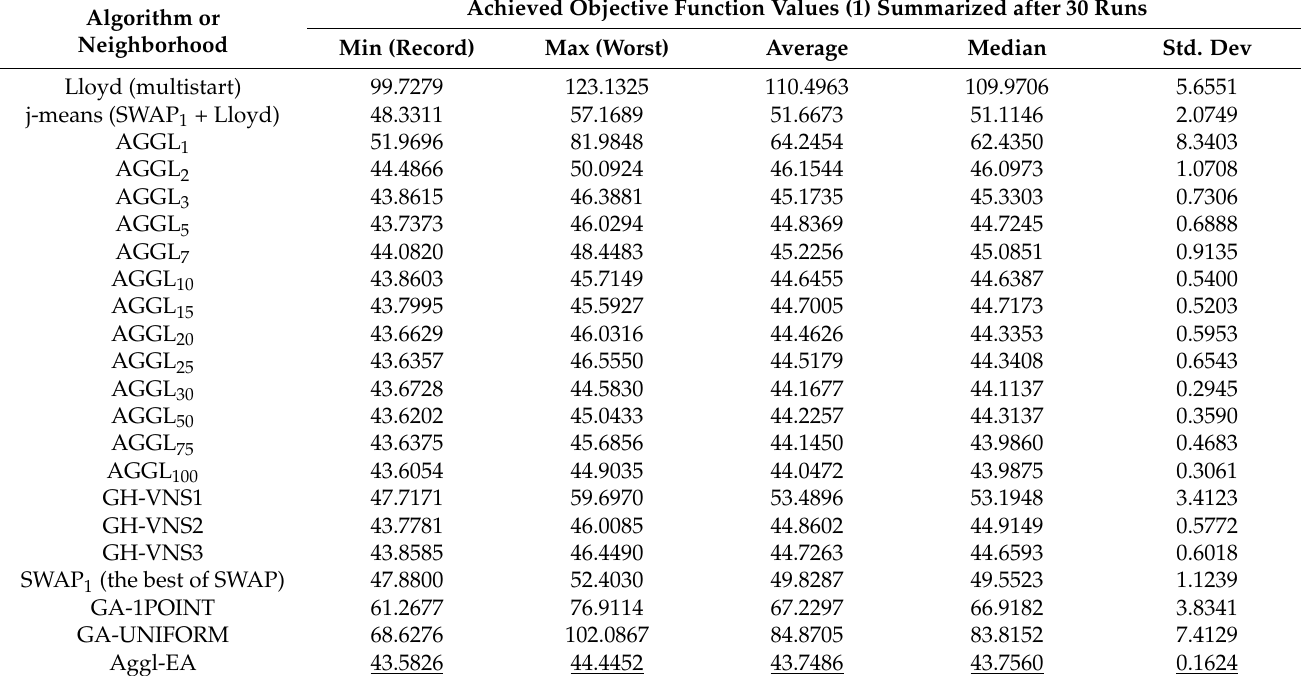
Table A8. Comparative results for Mopsi-Joensuu dataset. 6014 data vectors in R 2 , p = 100 centers, time limitation 5 s. Algorithm